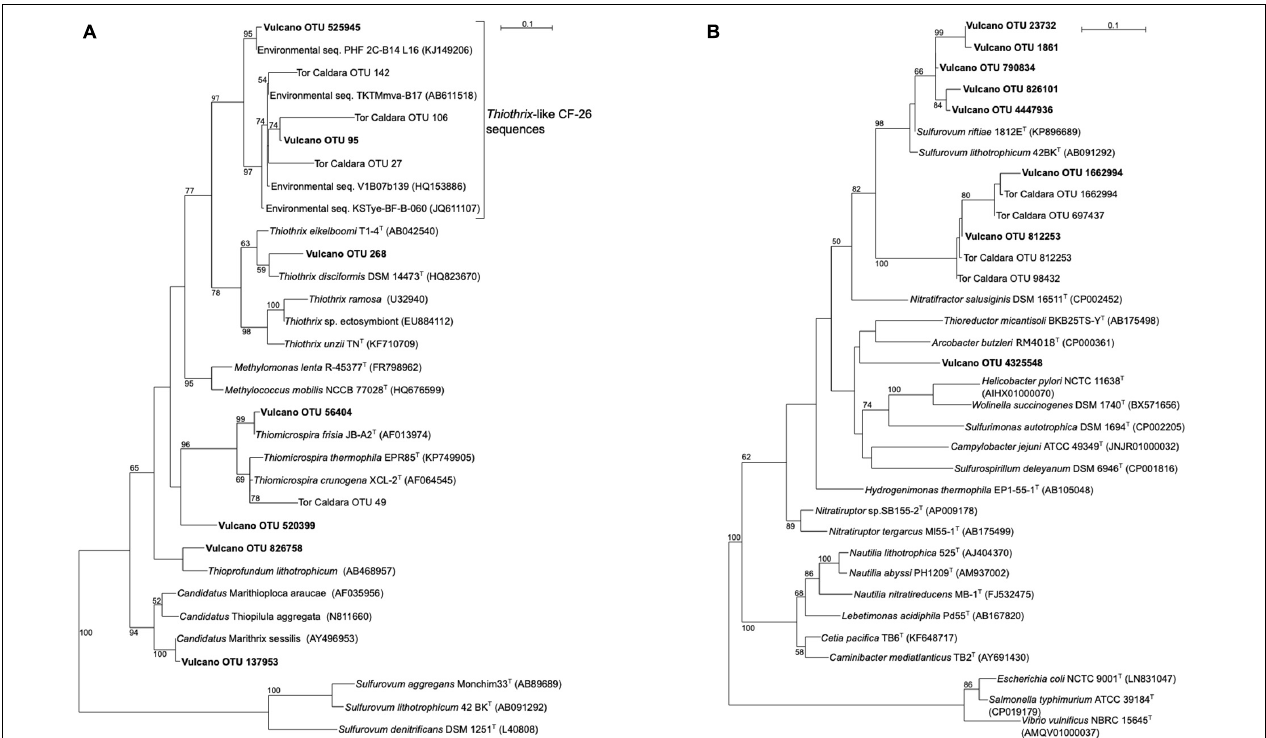
FIGURE 3 | Maximum-likelihood phylogenetic trees derived from 16S rRNA transcript sequences from Vulcano. aLRT branch support values higher than 50% were based on 1000 replicates and are shown at each node. Bar, 0.1% substitutions per position. Tor Caldara sequences were reported in Patwardhan et al. (2018). (A) Phylogenetic tree showing sequences related to sulfide-oxidizing Gammaproteobacteria (in boldface). Sequences belonging to the class Epsilonproteobacteria were used as outgroup. (B) Phylogenetic tree showing sequences related to sulfide-oxidizing Epsilonproteobacteria (in boldface). Sequences belonging to the class Gammaproteobacteria were used as